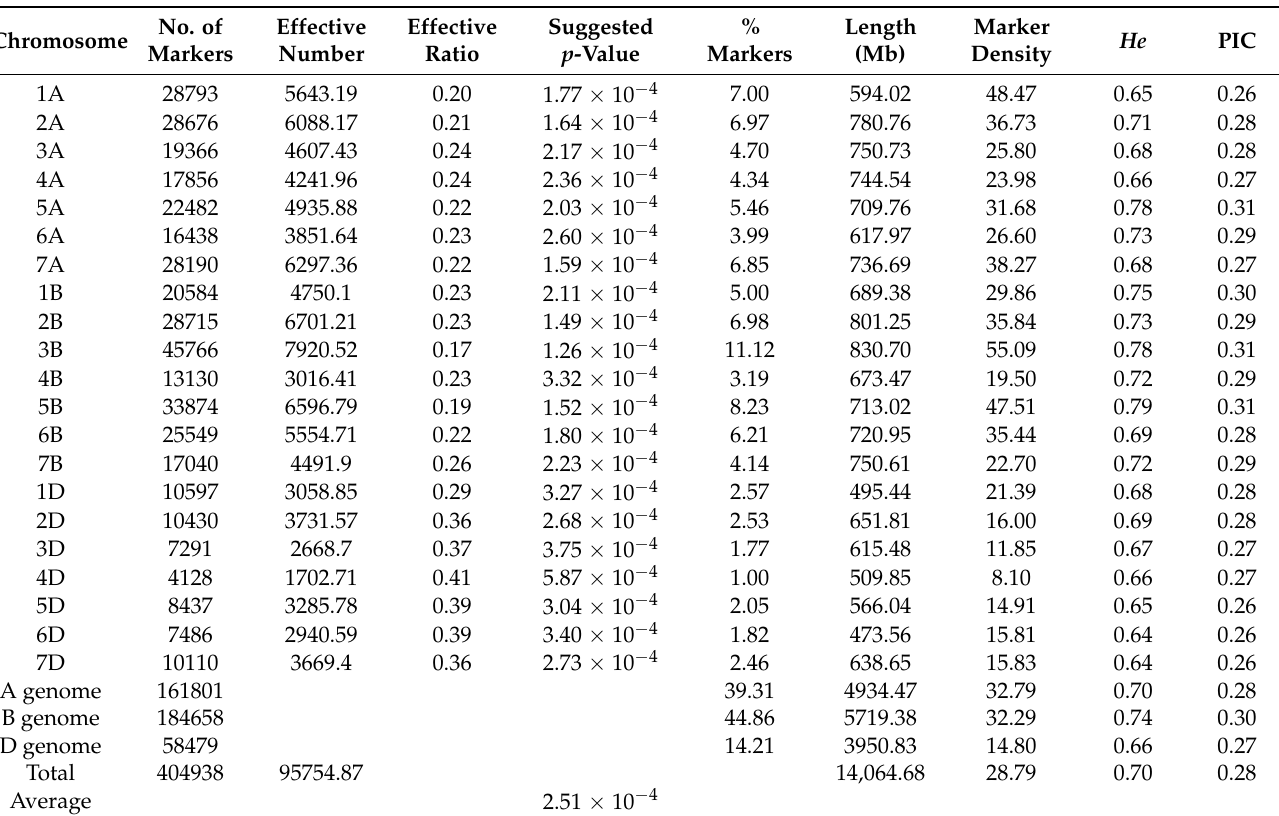
Table 3. Summary of the genetic diversity in three sub-genomes and chromosomes of this wheat panel and evaluation of the effective number of independent SNPs, including the suggested p - value